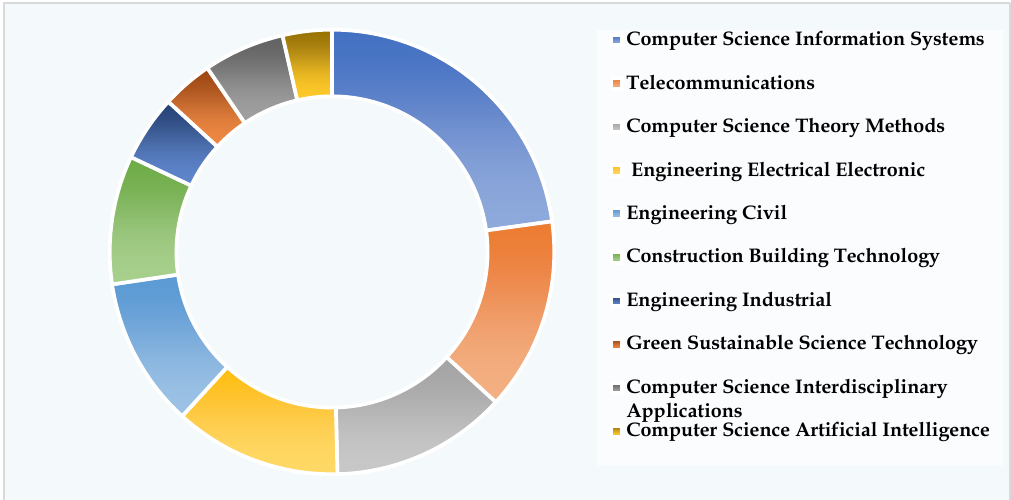
Figure 12. Classification of top subjects.